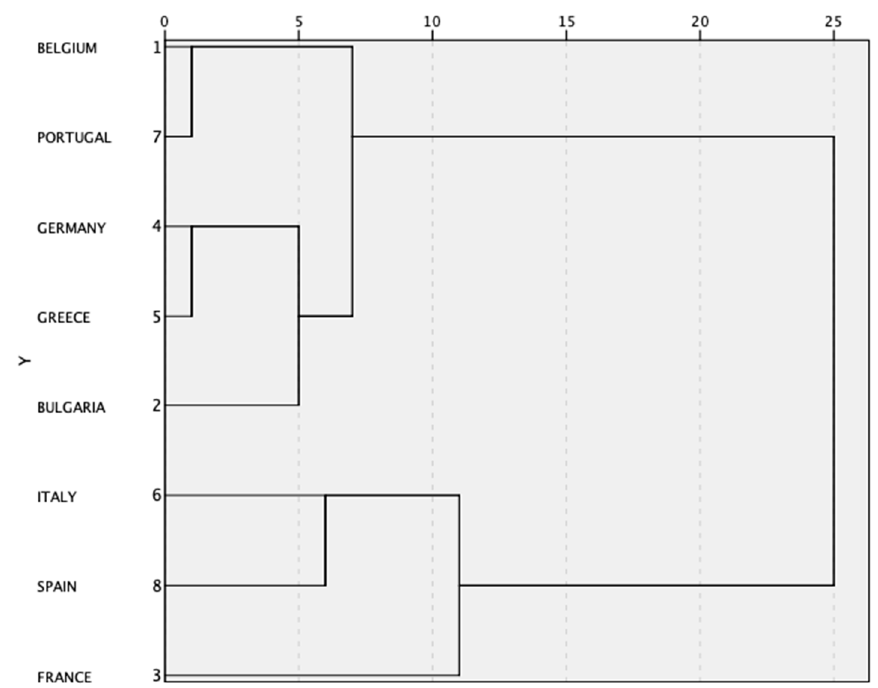
Figure 2. Cluster analysis result.